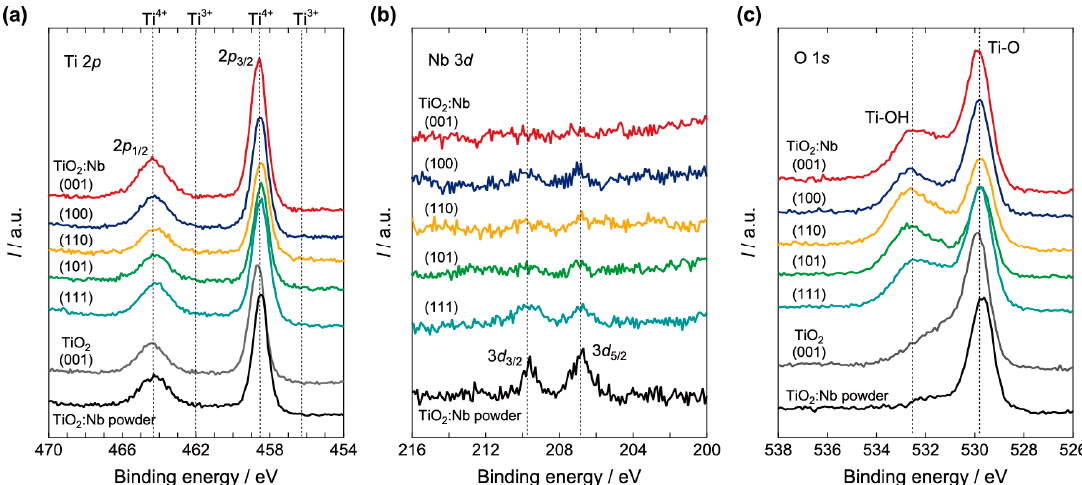
Figure 3. XPS spectra for ( a ) Ti 2 p , ( b ) Nb 3 d , and ( c ) O 1 s core levels in the TiO 2 :Nb (TiO 2 ) single-crystal substrates and TiO 2 :Nb 2 O 5 polycrystalline powder.